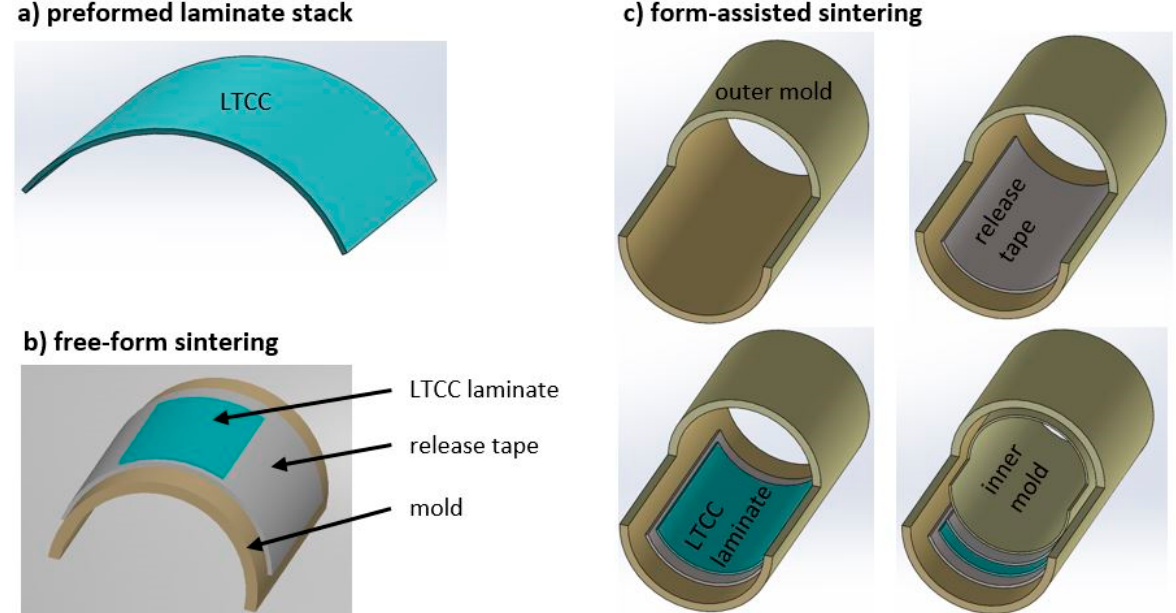
Figure 1. Scheme of form sintering: ( a ) preformed low-temperature cofired ceramics (LTCC) laminate; ( b ) free-form sintering: sintering the preformed low-temperature cofired ceramics (LTCC) laminate with the help of one mold and gravity; ( c ) form-assisted sintering: sintering the preformed LTCC laminate between two molds for dimensional accuracy.